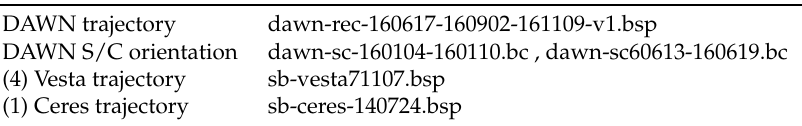
Table 2. SPICE kernels used in this study.